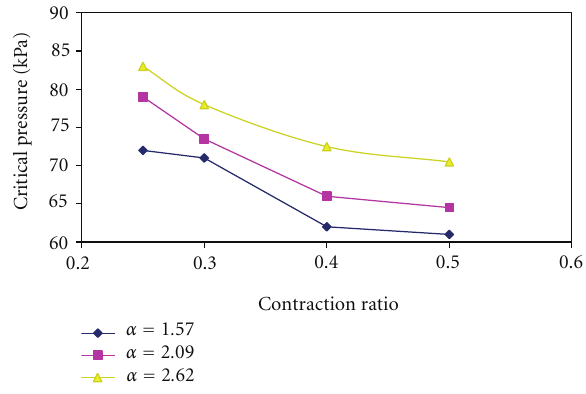
Figure 4: E ff ects of throat contraction ratio on critical pressure of Venturi